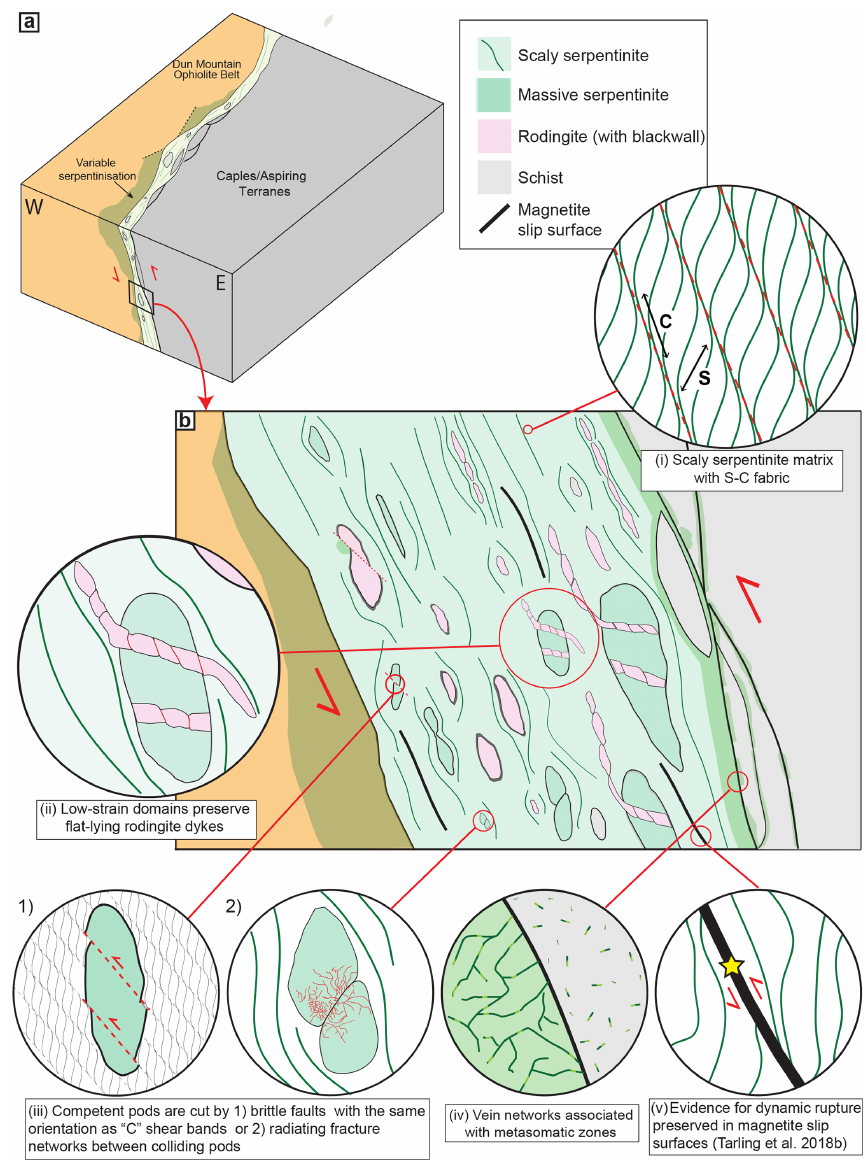
Figure 12. A conceptual model of the structure and composition of large serpentinite shear zones based on the most important structural elements and deformation processes observed in the Livingstone Fault. (a) Regional-scale characteristics. The thickness of the Livingstone Fault and the degree of serpentinisation in the DMOB wall rocks are highly variable along strike. The Caples–Aspiring wall rocks are cut by networks of brittle faults that enclose large lenses of fractured and metasomatised schist. (b) Internal structure and composition. (i) Scaly matrix serpentinite with a pervasive, steeply dipping foliation. (ii) “Low-strain domains” of massive serpentinite preserve flat-lying rodingite dykes that are sheared into the surrounding scaly matrix. (iii) Pods contain (1) brittle faults with a similar orientation to the “C” shear bands or (2) fracture networks that radiate outwards from contact regions between colliding pods. (iv) Metasomatic reactions led to the development of vein networks at the contact between serpentinite and the Caples–Aspiring Terrane. (v) Discrete magnetite-coated slip surfaces preserve evidence for dynamic rupture and coseismic dehydration of serpentinite (Tarling et al.,